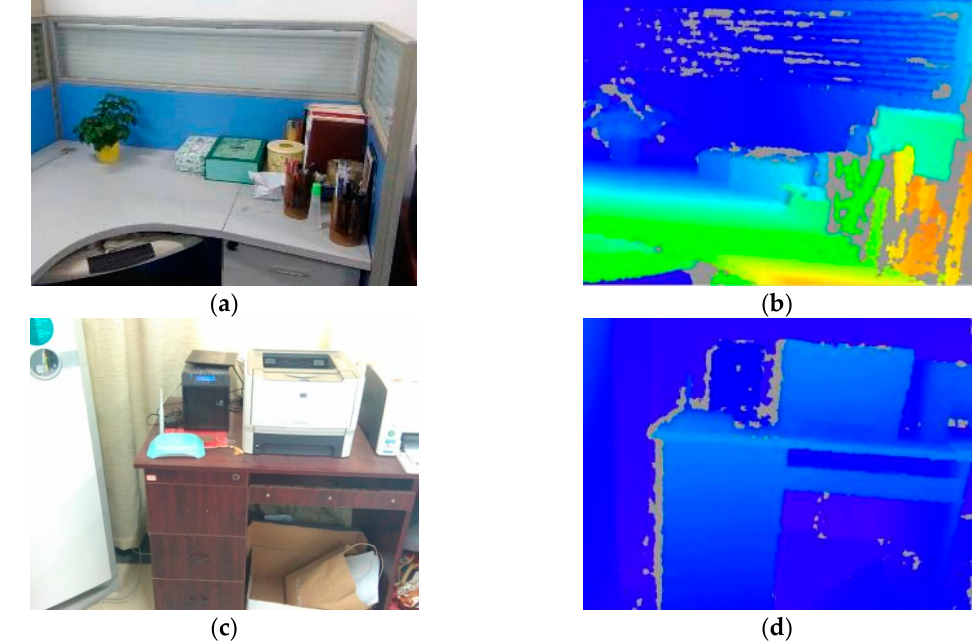
Figure 5. Reference images: ( a ) The RGB-D image of A; ( b ) The depth image of A; ( c ) The RGB-D image of B; ( d ) The depth image of